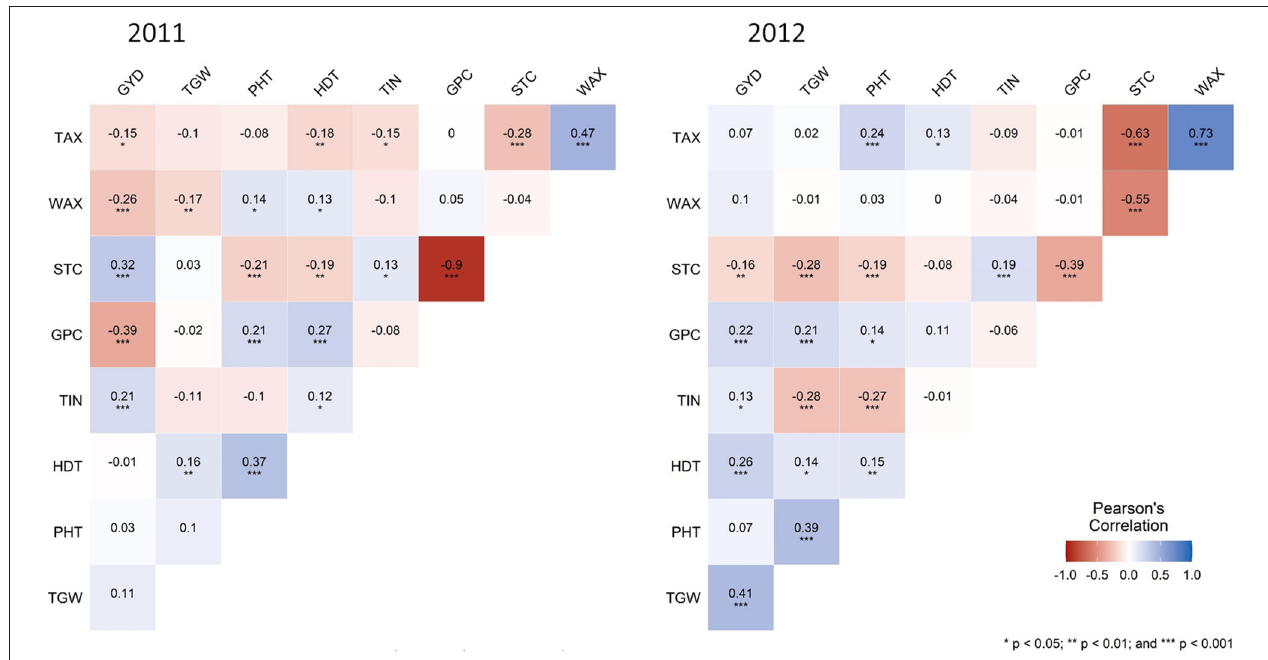
FIGURE 2 | Heatmaps of Pearson’s correlation coefficients for nine agronomic and quality traits in rye. Blue color indicates positive correlation and red color indicates negative correlation among different traits, with color intensity variance depicting the strength of correlation. GYD, grain yield; TIN, tiller number; TGW, thousand-grain weight; PHT, plant height; HDT, heading date; GPC, grain protein content; WAX, water extractable arabinoxylan content; TAX, total arabinoxylan content; STC, starch content. Categorization: 0.25 ≤ r < 0.45 weak, 0.45 ≤ r < 0.65 moderate, 0.65 ≤ r < 0.85 strong, 0.85 ≤ r very strong. * p < 0.05, ** p < 0.01, *** p < 0.001, blank for non-significant.